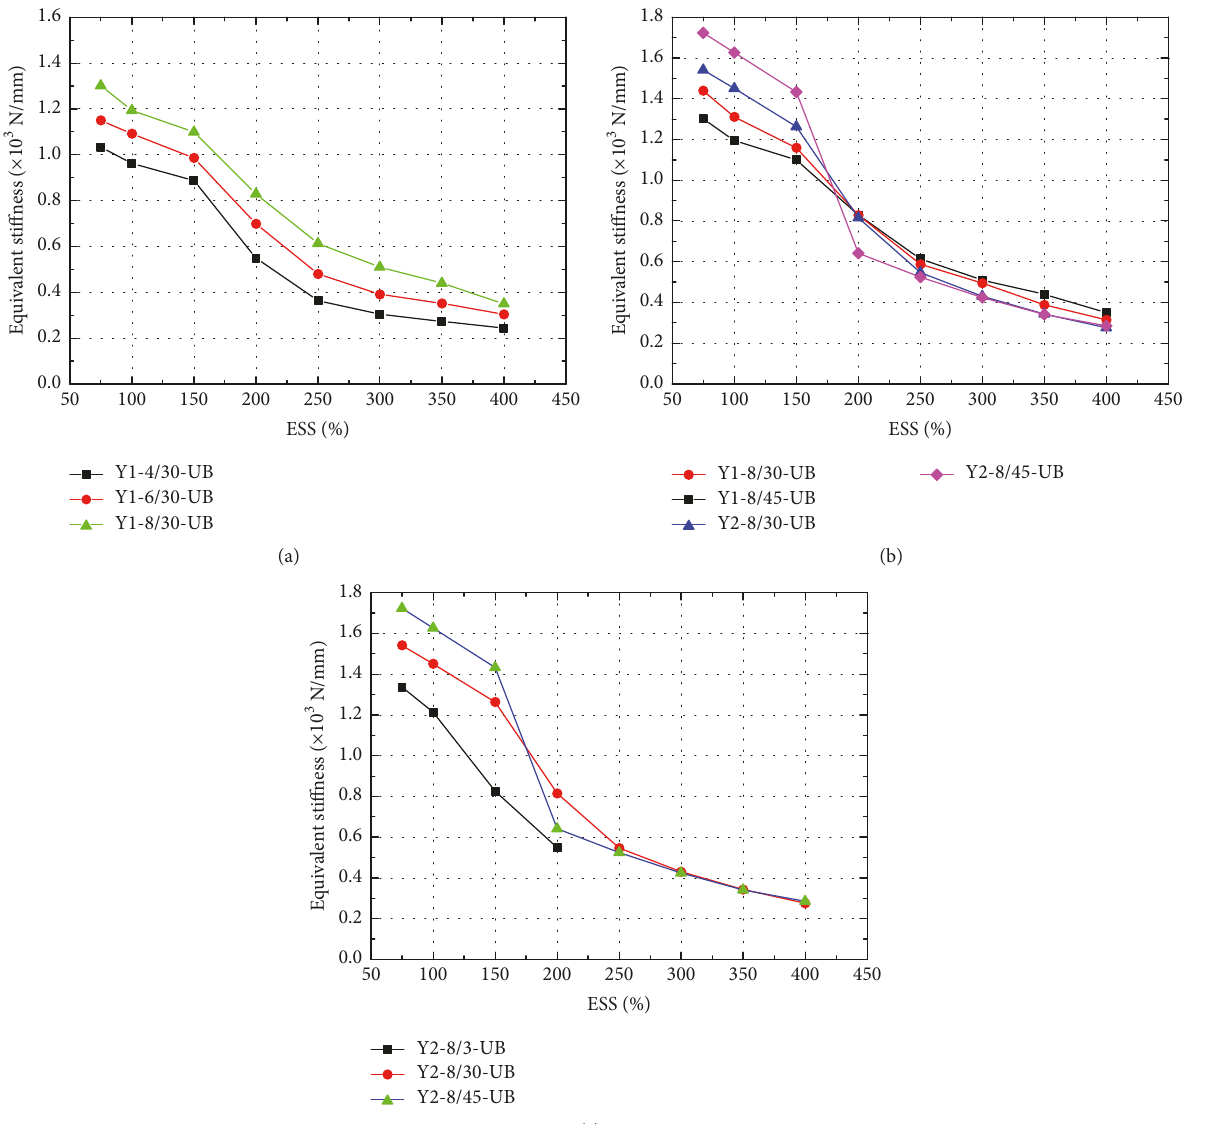
Figure 8: Observed equivalent stiffness versus ESS: (a) different vertical stresses; (b) different rubber materials; (c) different loading rates.